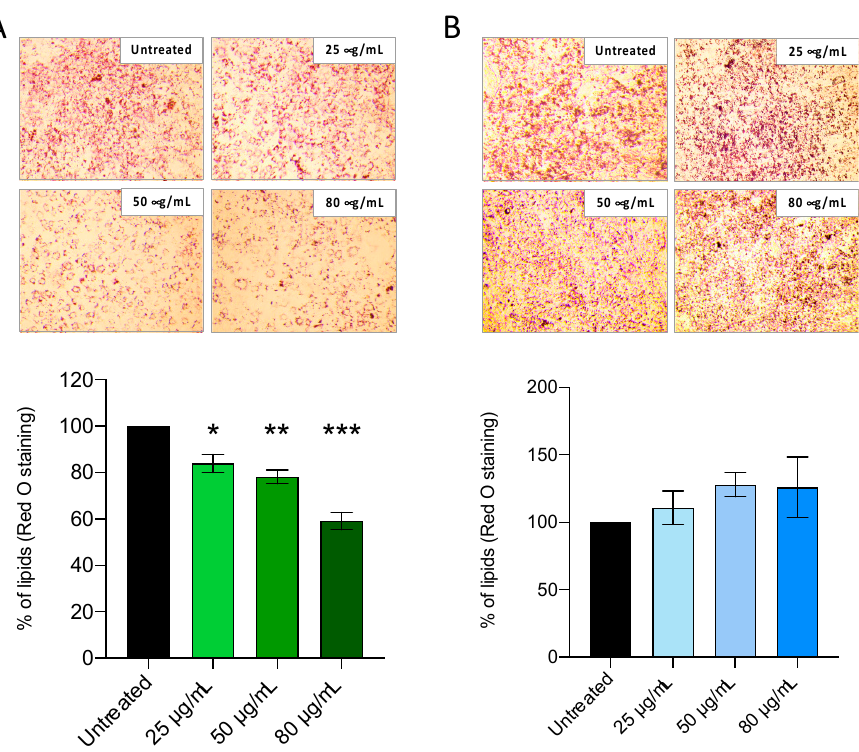
Figure 3. Effect of Ficus carica phytoextract collected ( A ) in autumn (FCa,) and ( B ) in spring (FCs) on 3T3-L1 lipid accumulation evaluated with Red O Staining. Data are shown as mean ± SEM; * p < 0.05; ** p < 0.01; *** p < 0.001 vs. control group (untreated).